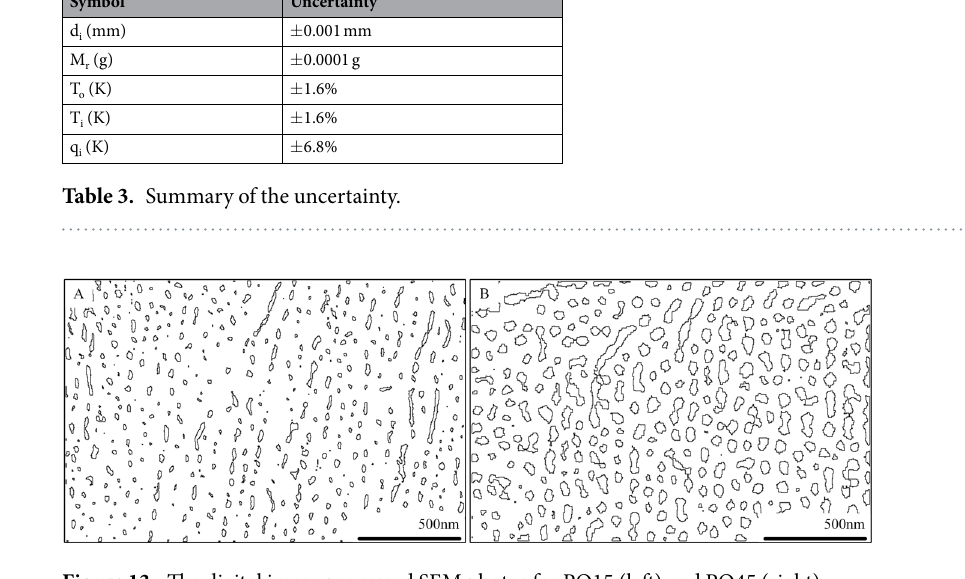
Figure 13. The digital image processed SEM photos for PO15 (left) and PO45